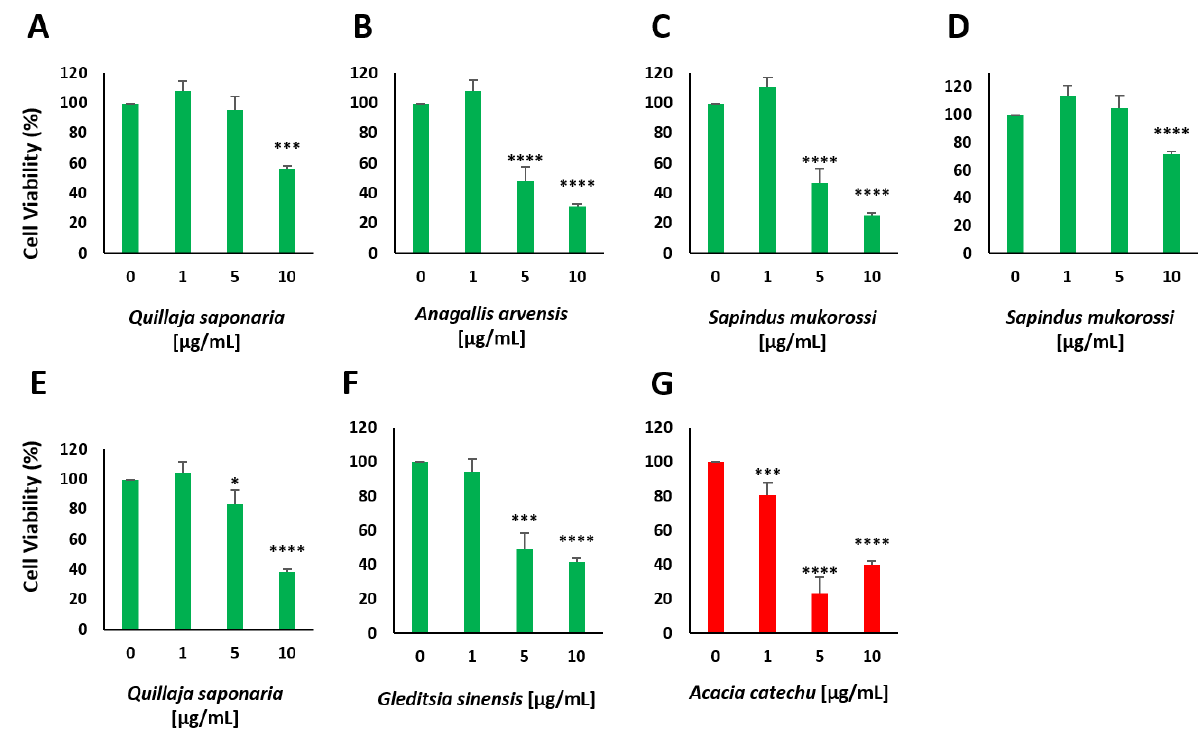
Figure A3. Cell viability of MIN6 pancreatic β cells after treatment with different concentrations of different extracts as determined by the resazurin assay. Quillaja saponaria ( A ), Anagallis arvensis ( B ), Sapindus mukorossi ( C ), Sapindus mukorossi ( D ), Quillaja saponaria ( E ), Gleditsia sinensis ( F ) and Acacia catechu ( G ). * p < 0.05; *** p < 0.001; **** p < 0.0001.